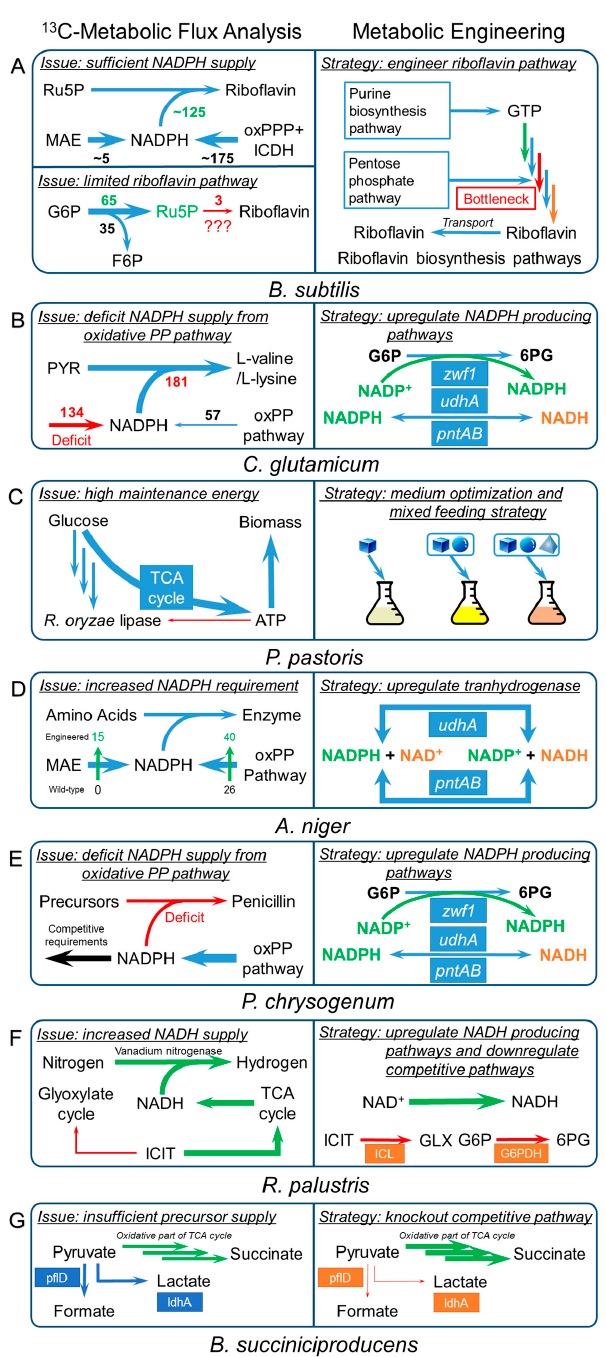
Figure 4. Integration of the key discoveries from 13 C-MFA and the corresponding metabolic engineering strategies for ( A ) B. subtilis ; ( B ) C. glutamicum ; ( C ) P. pastoris ; ( D ) A. niger ; ( E ) P. chrysogenum ; ( F ) R. palustris ; and ( G ) B. succiniciproducens .